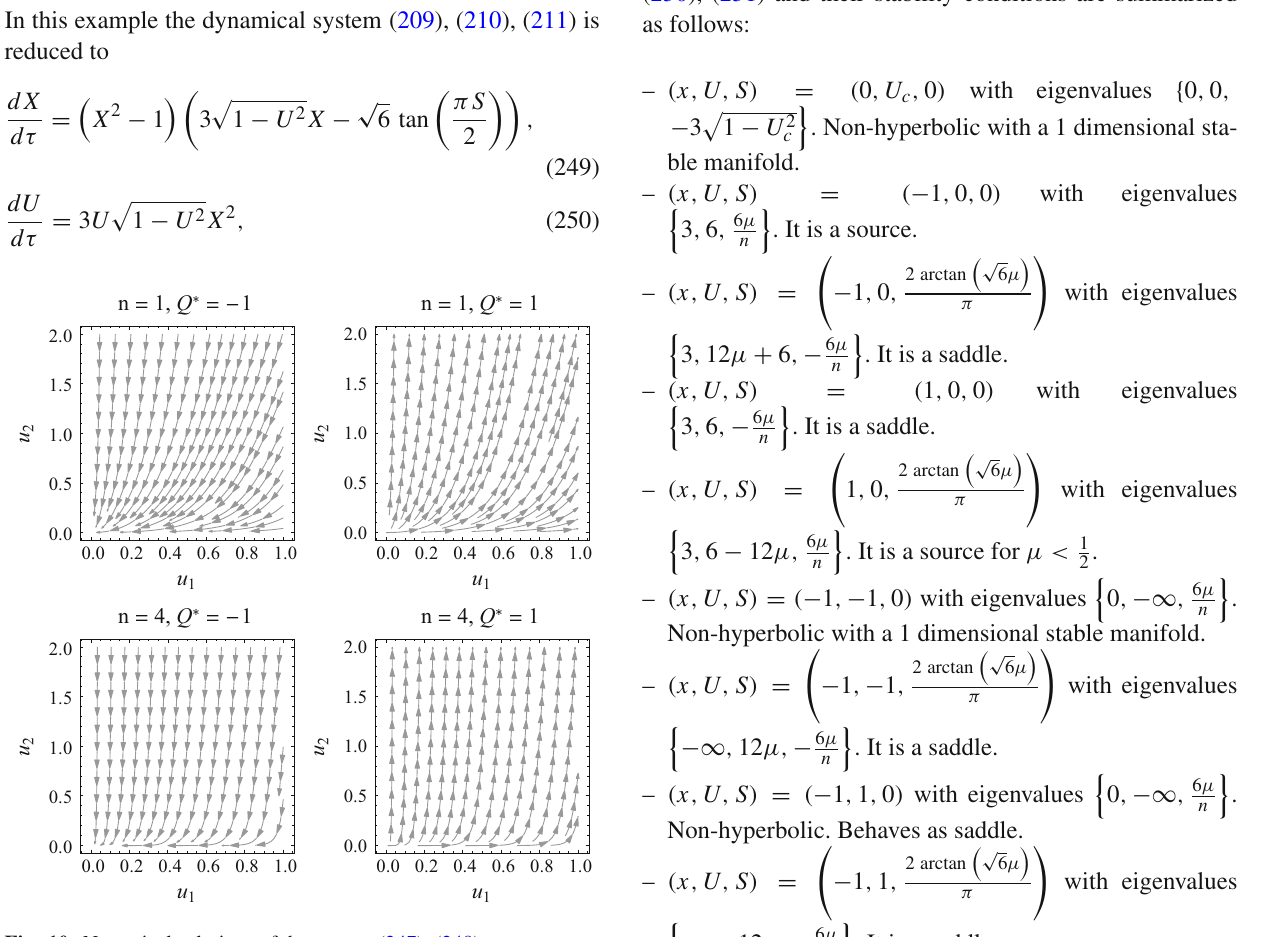
Fig. 10 Numerical solutions of the system (247),